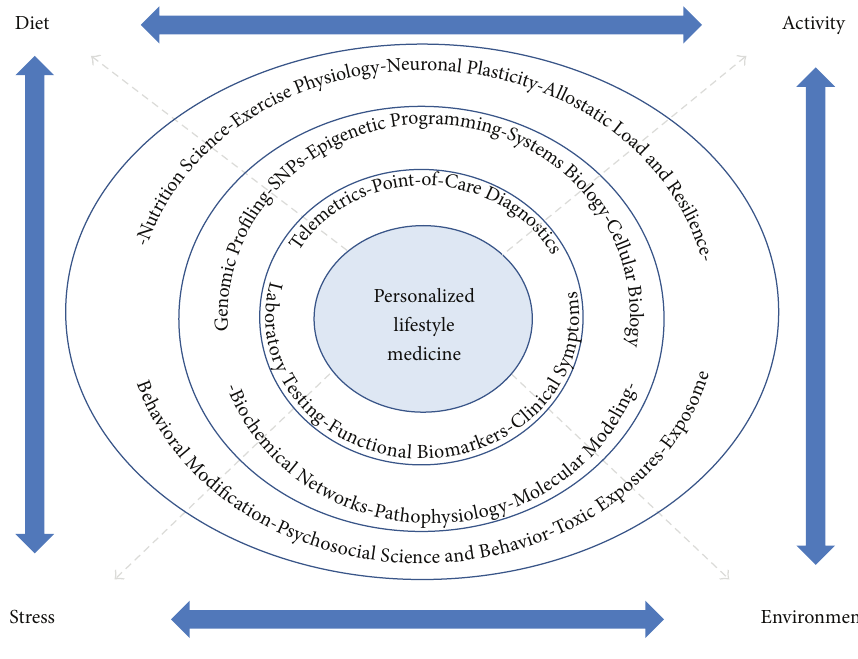
Figure 3: What is personalized lifestyle